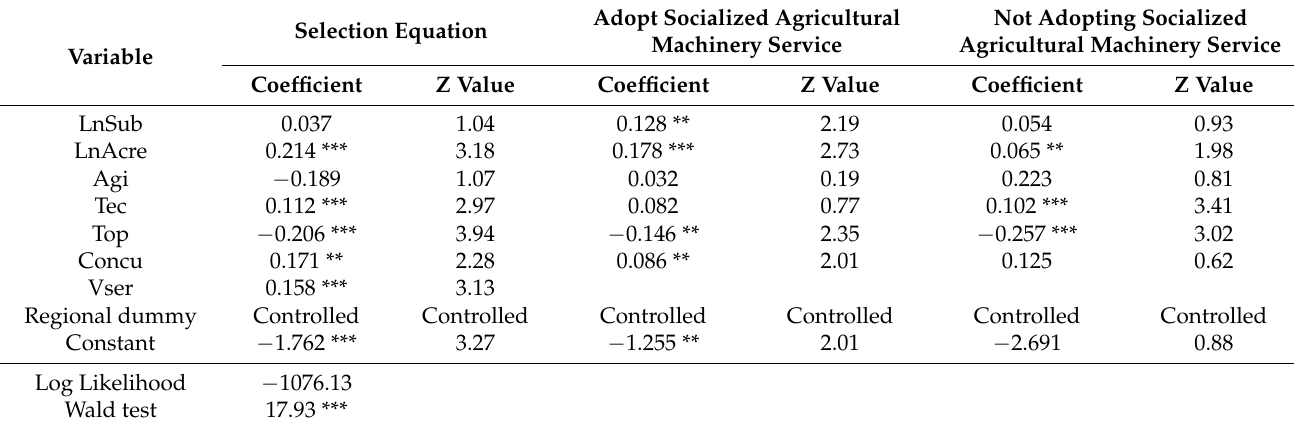
Table 4. Estimation results of endogenous switching regression